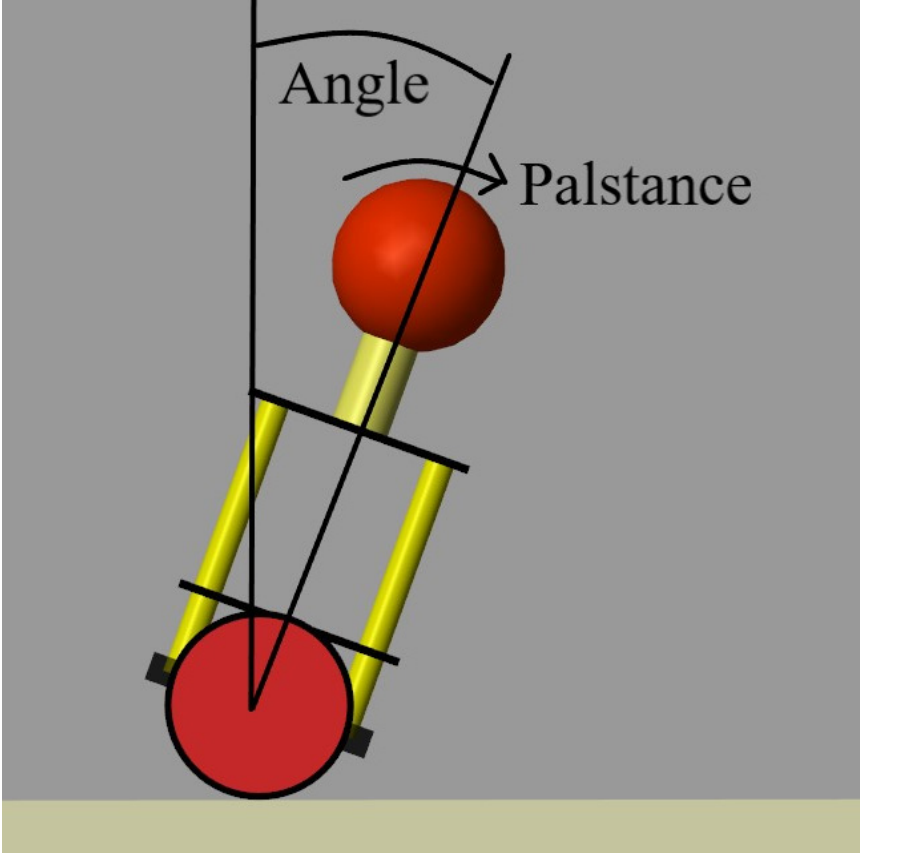
Figure 3. The model of the balancing robot.